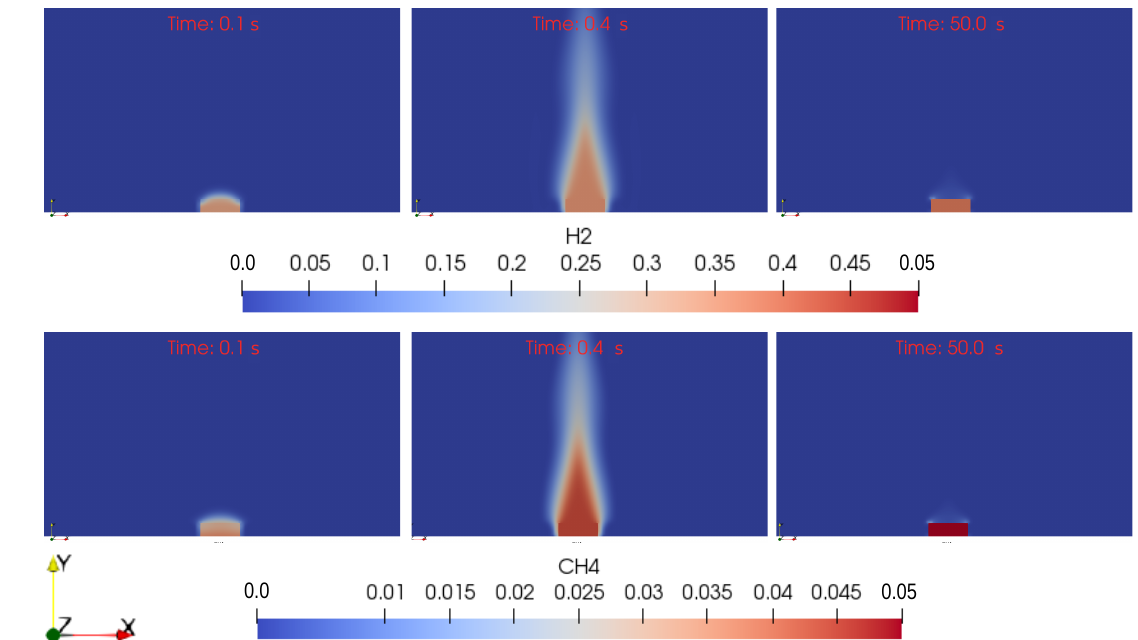
Figure 8. Concentration of hydrogen and methane in the simulation. It can be observed how their concentration is time dependent. At time t = 0.1 s the concentration of the gases in the environment region is close to zero. With time, thanks to the advancement of pyrolysis, their concentration increases. For the two gases different values of concentration are reached. At time t = 50 s it can be see that the fire has consumed the two species and their concentration is again nearly zero.